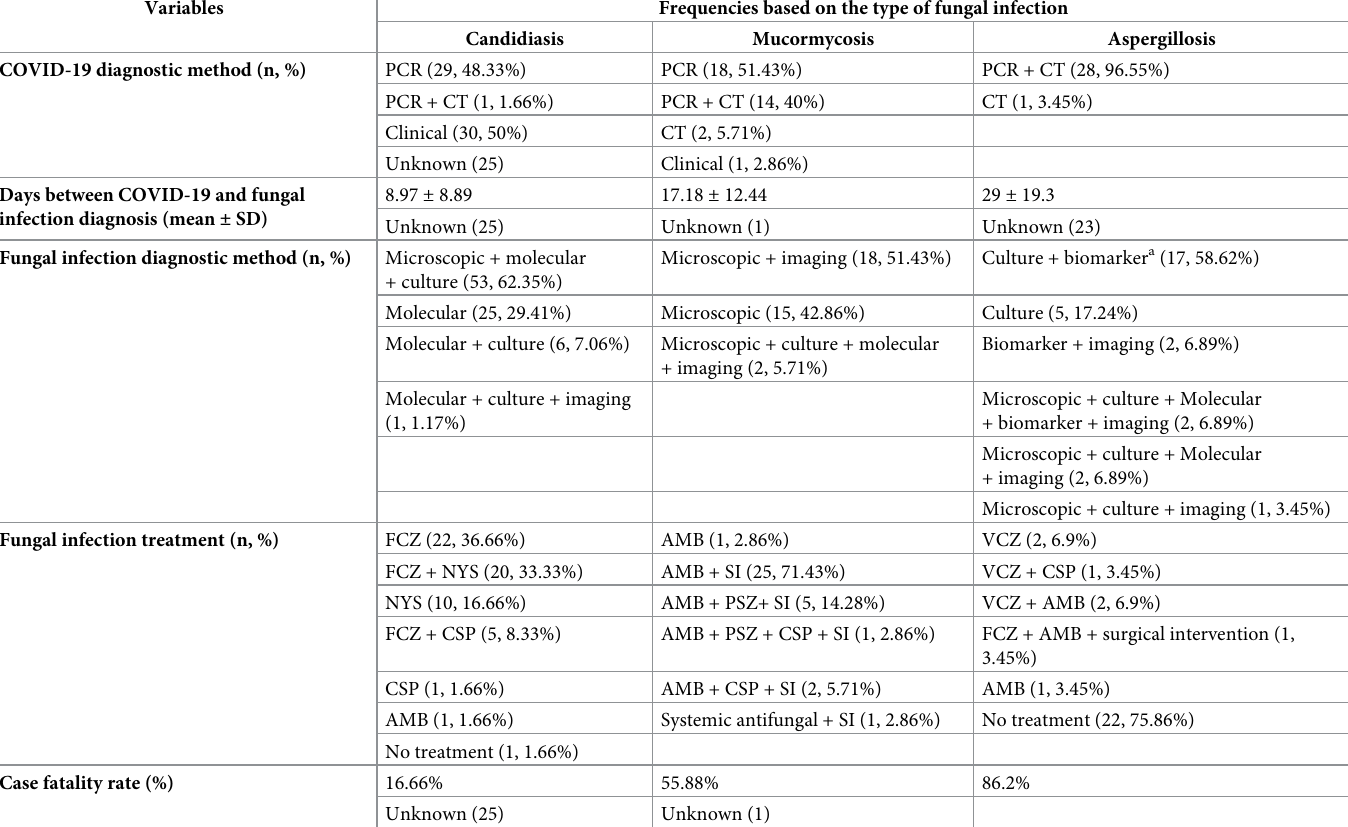
Table 3. Description of diagnosis, treatment and outcome of COVID-19-associated fungal infection cases reported from Iran up to November 5,